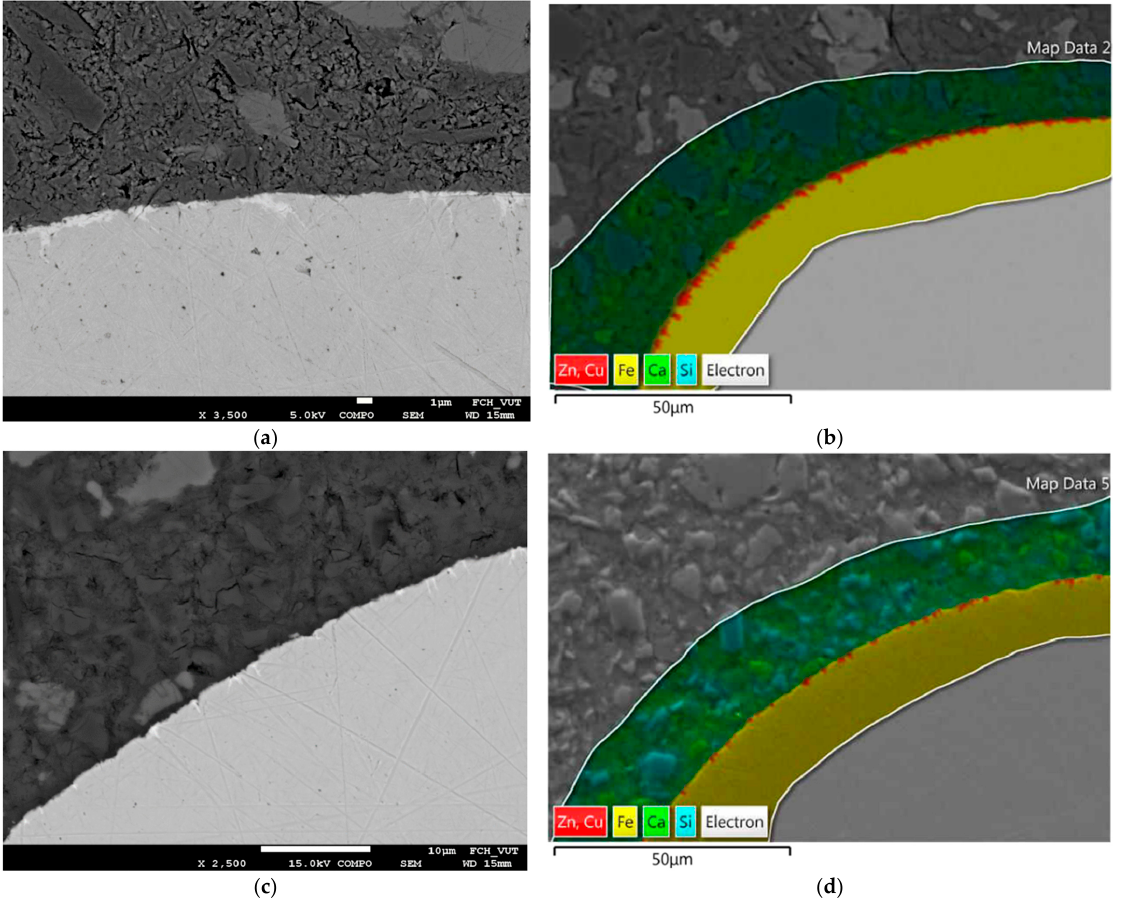
Figure 6. BSEM images and EDS analysis of the fiber-matrix interface: ( a ) BSEM image of the fiber-matrix interface of the composite with brass coated fibers; ( b ) EDS analysis of the fiber-matrix interface of the composite with brass coated fibers; ( c ) BSEM image of the fiber-matrix interface of the composite with fibers treated in NH 3 /H 2 O 2 ; ( d ) EDS analysis of the fiber-matrix interface of the composite with fibers treated in NH 3 /H 2 O 2.